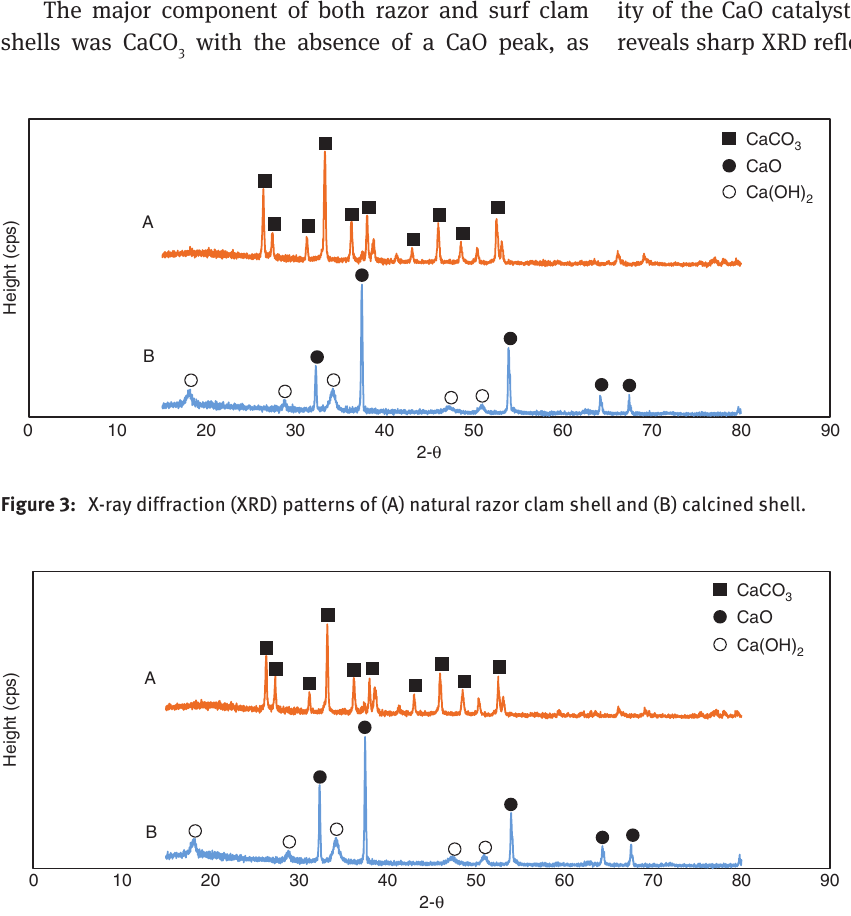
Figure 4: X-ray diffraction (XRD) patterns of (A) natural surf clam shell and (B) calcined shell.